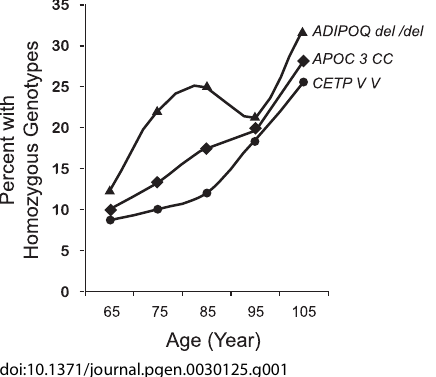
Figure 1. Visual Presentation of the Frequency Trends of Favorable Genotypes with Exceptional Longevity